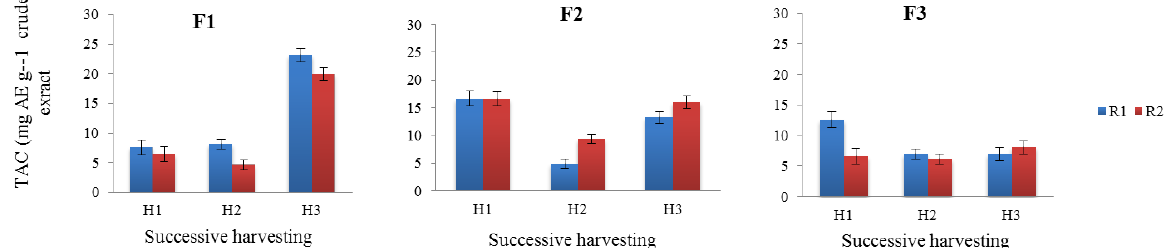
Fig. 3. Effect of fertilizer type (F), rate (R) and successive harvesting (H) on total alkaloid content (TAC). Note: F1: NPK 15-15- 15; F2: NPK 8-8-8; F3: NPK 5-5-5; R1: 12.5 kg N/ha; R2: 25 kg N/ha; H1: 1st harvest; H2: 2nd harvest; H3: 3rd harvest. Error bars represent standard error